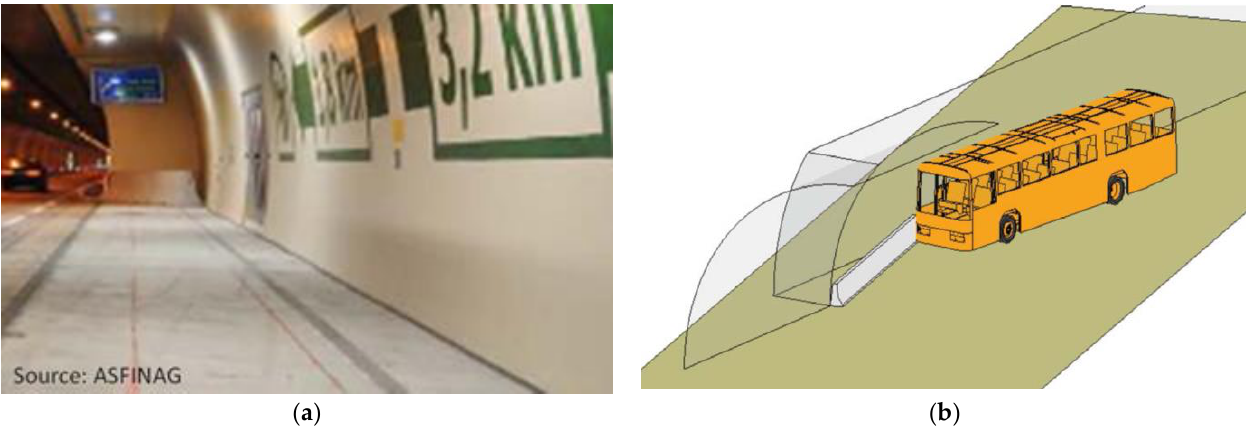
Figure 4. Tunnel lay-by protection measure. ( a ) angular positioned concrete barrier [43] and ( b ) crash cushion at the end-wall of the tunnel lay-by [41].